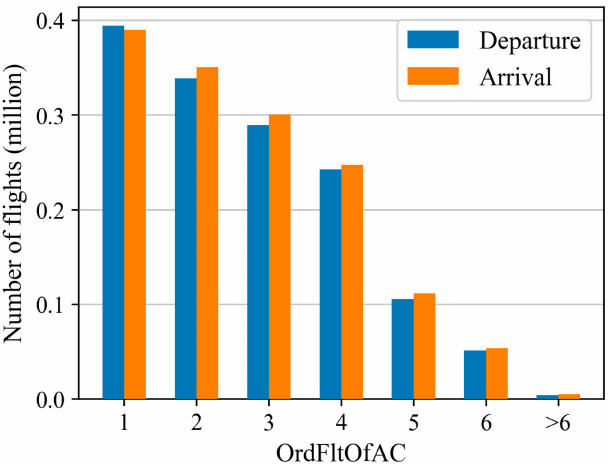
Figure 2. Distribution of the order of flight legs flown by aircraft in